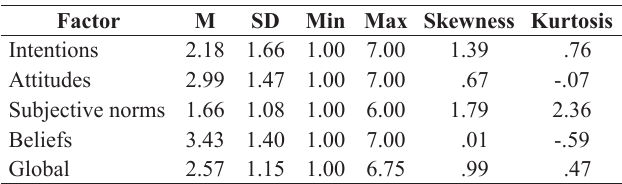
Table 1. Factor descriptive statistics for